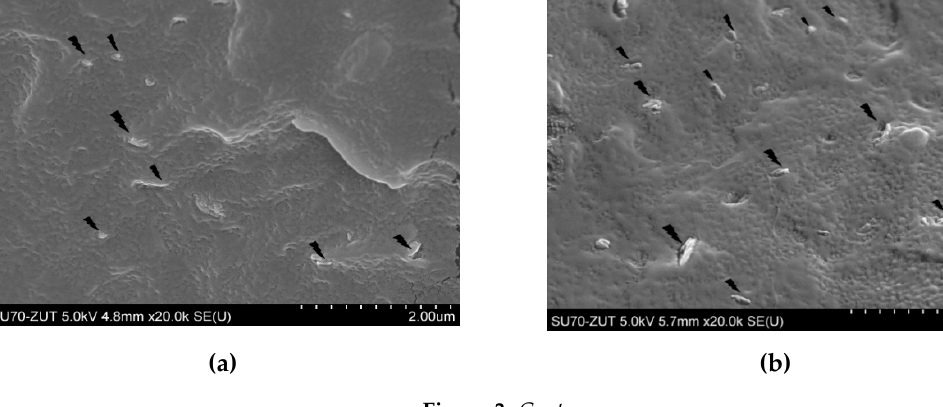
(d) Figure 3. SEM images of PP/HNT NCs ( a ) 1 vol.%, ( b ) 2 vol.%, ( c ) 5 vol.%, and ( d ) 10 vol.% of HNTs. 3.2. Mechanical Properties Figure 4 depicts the averaged stress – strain curves of manufactured composites tested in tensile mode. The Young’s modulus of PP increases after the addition of HNTs. Already after adding 1 vol.% of HNTs, the gain of Young’s modulus is 14% concerning the neat PP matrix. The higher the content of HNTs, the greater the Young’s modulus of PP/HNTs NCs, which is increased by ~60% with 10 vol.% of HNTs. The Young’s modulus of PP increases up to ~260% with the addition of 30 vol.% of short kenaf fibers in PP. Nevertheless, in the case of hybrids, the addition of HNTs increases further the Young’s modulus of the composite by 3%, 5%, 9%, and 13% in the case of adding the 1, 2, 5, and 10 vol.% of HNTs, respectively. The increase in Young’s modulus is attributed to Young’s modulus of the filling material, its volumetric content, and shape. It is calculated for very low deformations; therefore, it is not affected by the quality of filler – matrix interphase or the presence of agglomerates. However, these two factors play a more vital role in tensile strength [27]. It can be seen in Table 2 that the tensile strength of PP/HNTs NCs is enhanced by 5% and 3% with the addition of 1 and 2 vol.% HNTs to the pure PP matrix, respectively. Their ductility is also not reduced as they all break at around ~30% of strain. This gain can be attributed to reduced creep by the presence of HNT nanoclay or increased crystallinity owing to the nucleating effect of HNTs [28 – 30]. However, further addition of HNTs diminished the gain and for 10 vol.% content of HNTs, the tensile strength is even reduced by 7%, while the strain to break is reduced to 2.8%. The decrease in ductility of PP with a higher content of HNT nanoclay is related to the low structural ductility of its HNTs and nanoplates. Therefore, even the addition of MAH-g-PP compatibilizer, which develops interphase on the surface of HNTs, does not prevent them from debonding from the PP matrix at higher strains. Furthermore, the higher amount of agglomerates at higher volumetric content of HNTs can be a substantial factor